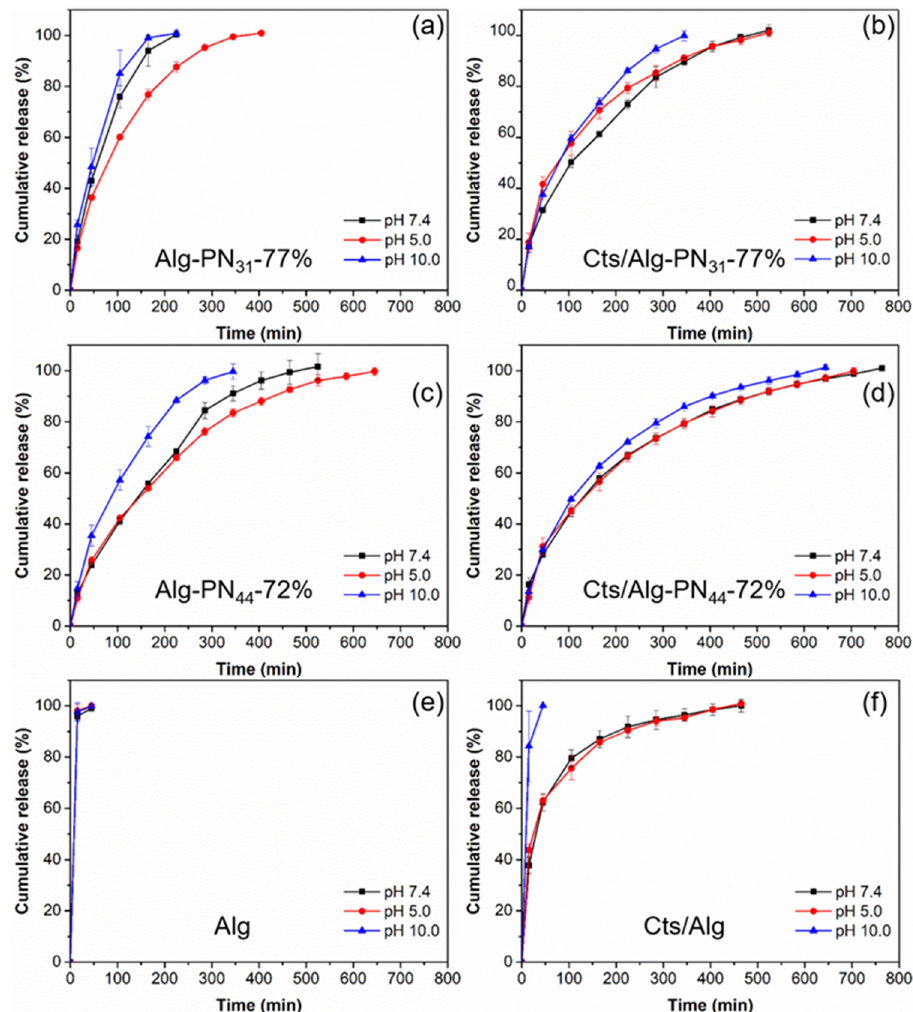
Figure 7. The release profiles of rhodamine B from the samples Alg-PN 31 -77% ( a ), Cts/Alg-PN 31 -77% ( b ), Alg-PN 44 -72% ( c ), Cts/Alg-PN 44 -72% ( d ), Alg ( e ), and Cts/Alg ( f ) at different pH and 37 °C.